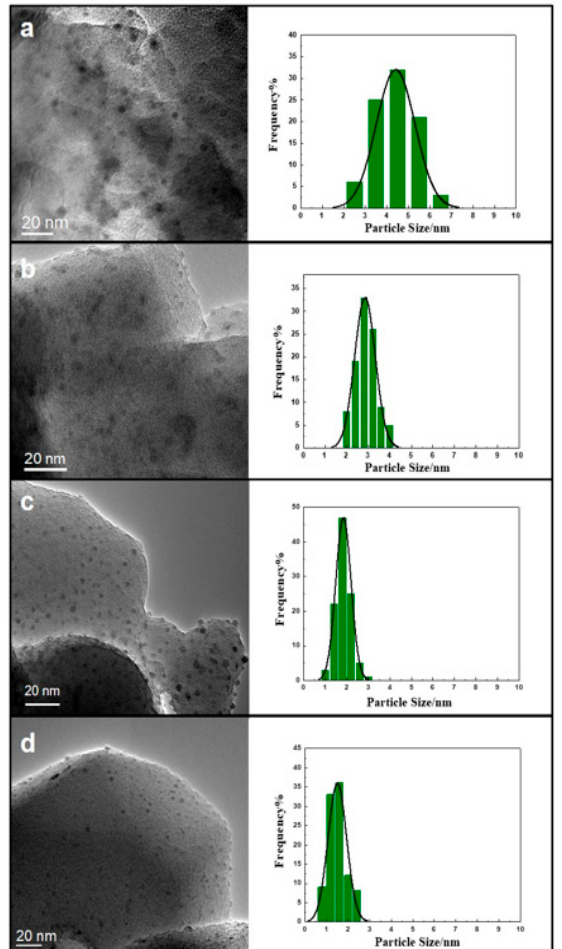
Figure 3. TEM images and particles size distribution of Zn–Sn–Pt modified defective MFI zeolites with different SiO 2 /Al 2 O 3 ratios. ( a ) ZnSnPt/HZ30, ( b ) ZnSnPt/HZ110, ( c ) ZnSnPt/HZ700, ( d ) ZnSnPt/S-1 catalysts.